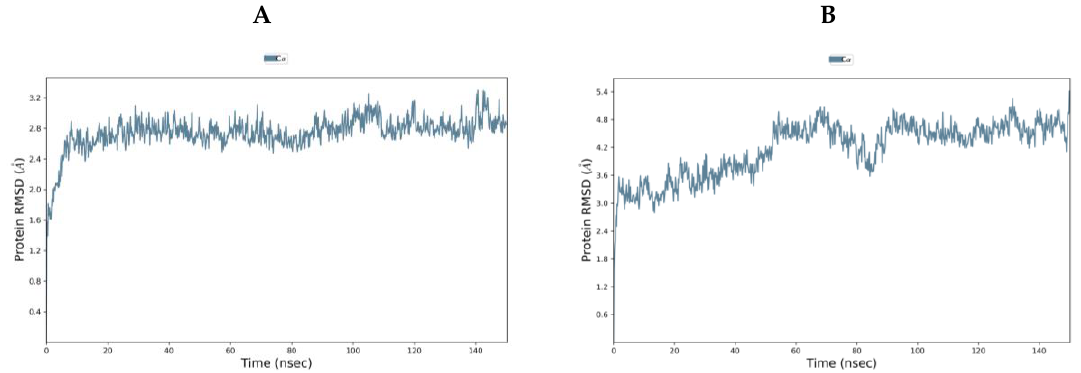
Figure 4. RMSD [Å ] plot with respect to time in nanoseconds during 150 ns MD stimulation of ( A ) Figure 4. RMSD [Å] plot with respect to time in nanoseconds during 150 ns MD stimulation of TMPS2 model 1 (5CE1_A template) and ( B ) TMPS2 model 2 (1Z8G_A template). ( A ) TMPS2 model 1 (5CE1_A template) and ( B ) TMPS2 model 2 (1Z8G_A template).